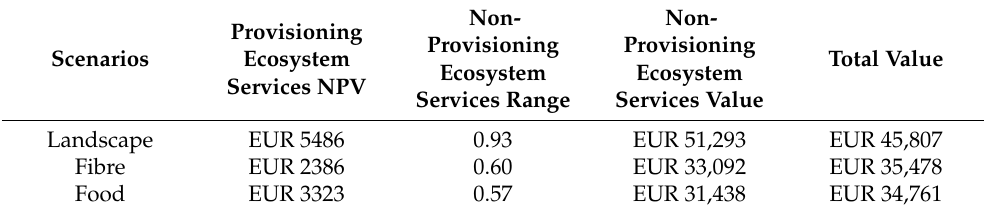
Table 3. New maximum contribution of ecosystem services per ha according to EU ETS Phase 4. Ecosystem Service Weight Value Temperature 25% Waterflow Erosion Air purification Carbon sequestration Humidity Total EUR 55,154